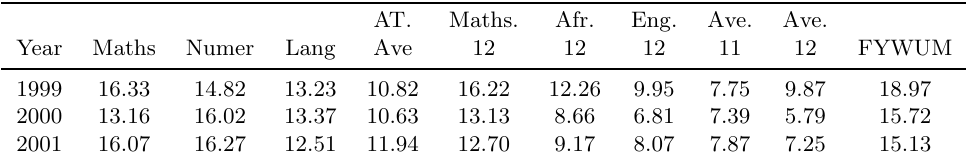
Table 6: Standard deviations of the variables of the Test Battery 2 data set for the 1999, 2000 and 2001 intake